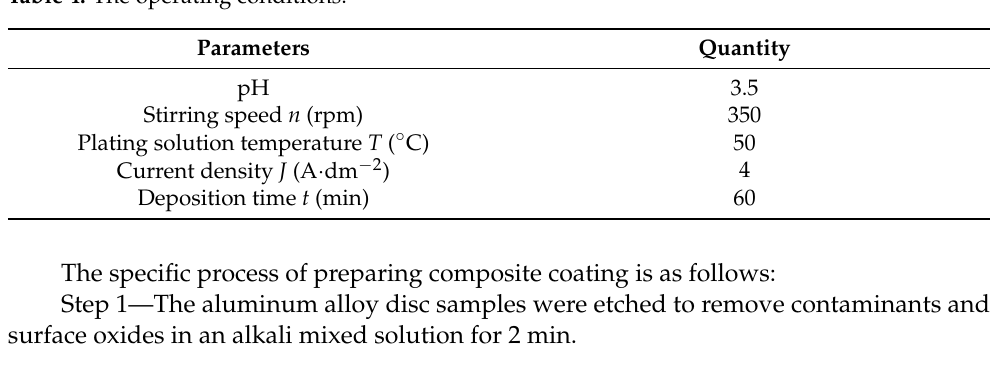
Table 4. The operating